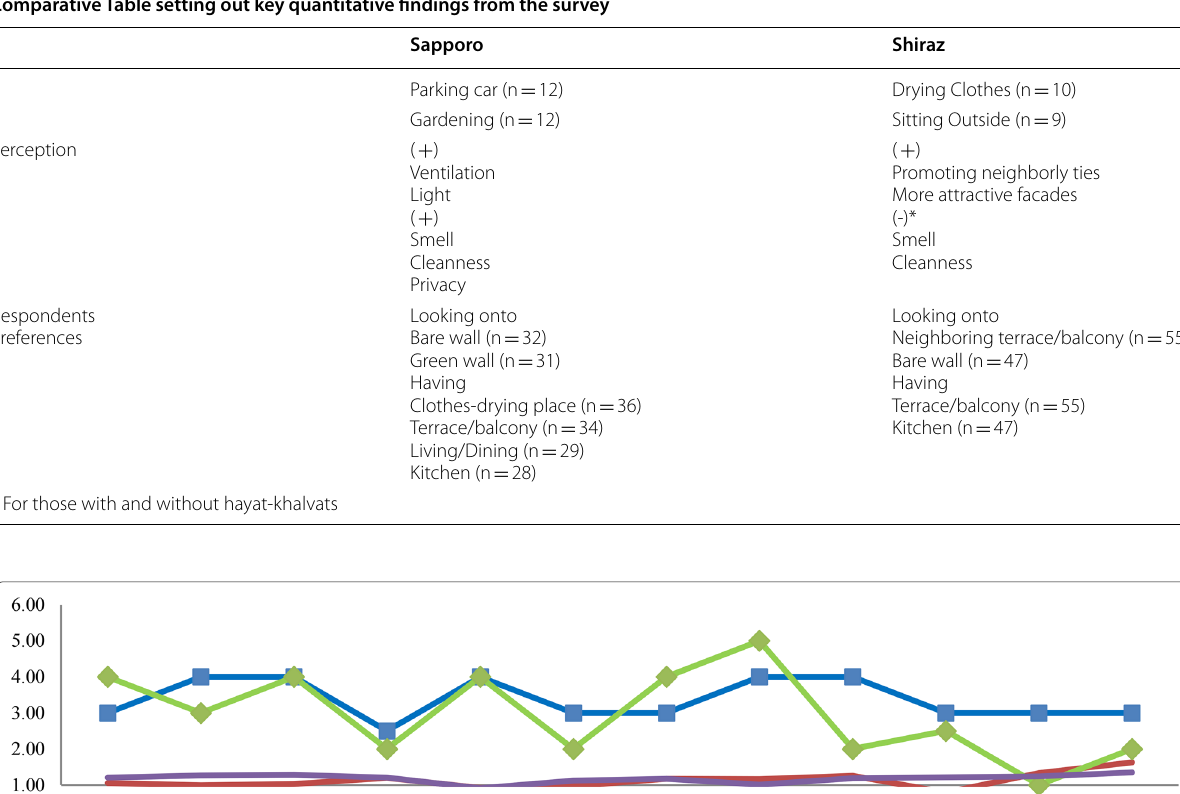
Table 4 Comparative Table with key quantitative findings from the survey Comparative Table setting out key quantitative findings from the survey